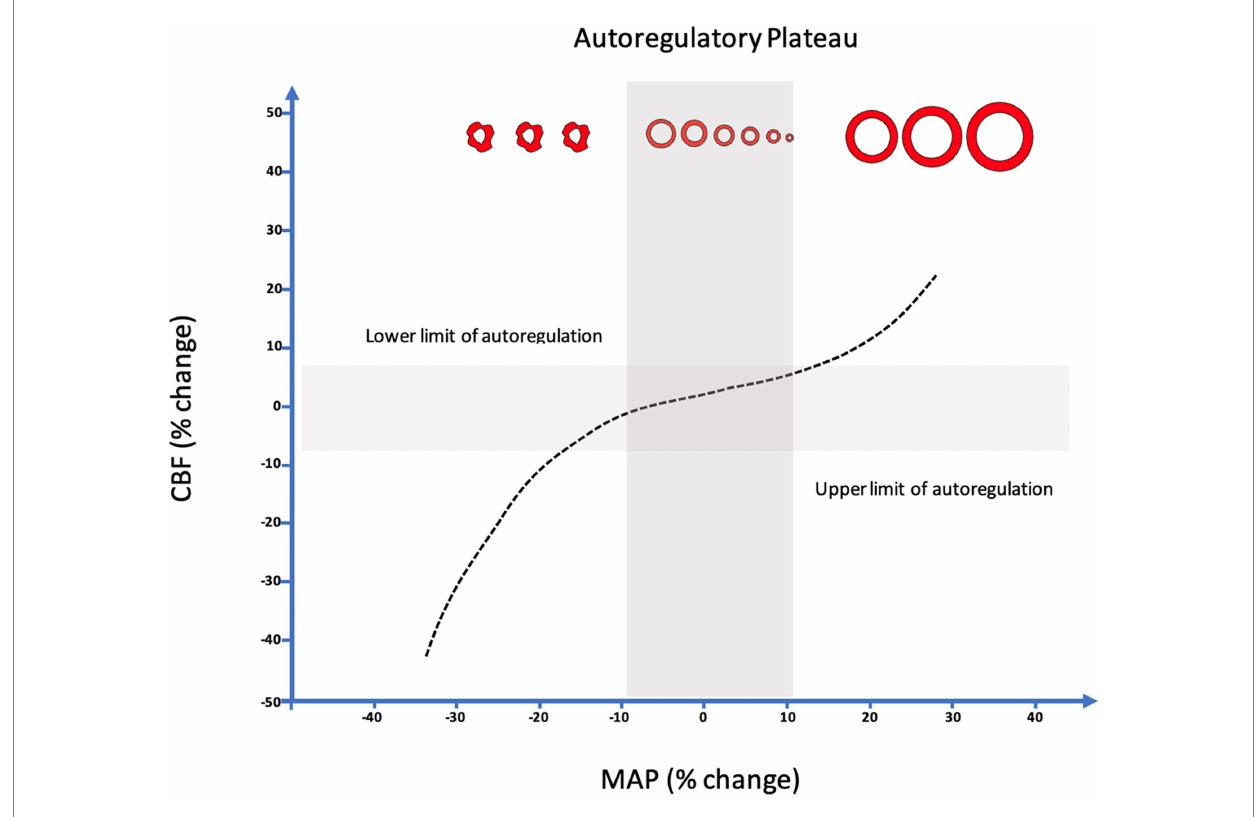
FIGURE 2 Relationship between changes in MAP from baseline ( Δ %MAP) and concomitant relative changes in CBF ( Δ %CBF). Upper and lower limits of autoregulation demonstrated by linear correlation between MAP and CBF indicative of pressure passive state. NB. The classic Lassen’s curve demonstrating a wide range of autoregulation (~50–150 mm hg) has been challenged. It is suggested that a narrow range of autoregulation (~15– 200 mm hg) is likely to be more common, even in healthy individuals, and is influenced by the rate of arterial pressure